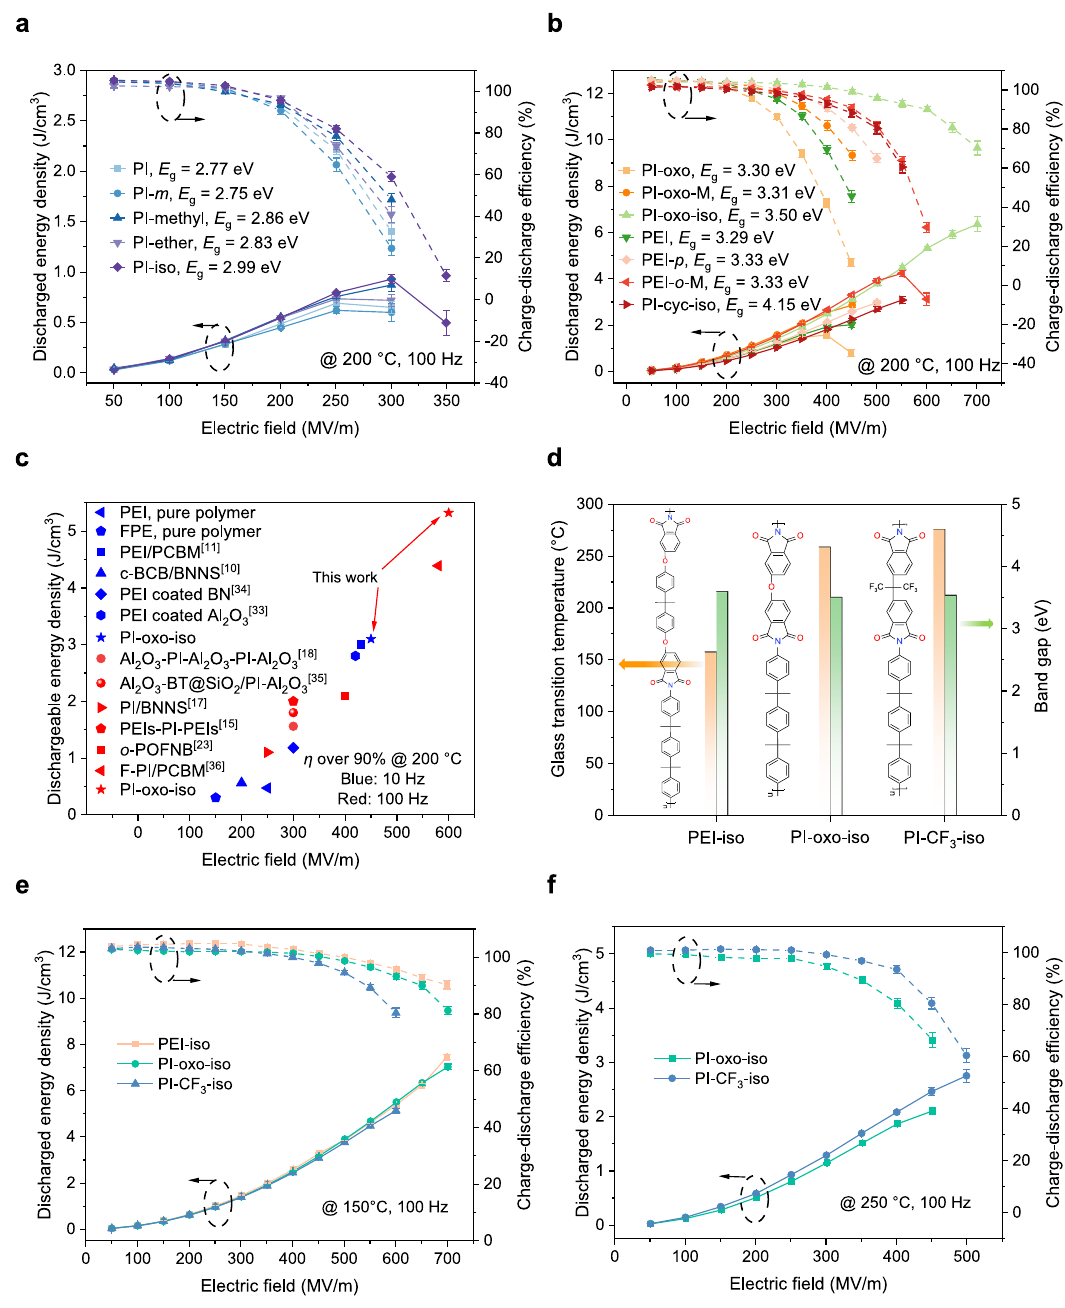
fi eld. d ComparisonofglasstransitiontemperatureandbandgapofPEI-iso,PI-oxo- iso,andPI-CF 3 -iso,thecorrespondingmolecularstructureformulaisshownonthe left side to the column diagram. e , f Discharged energy density and charge- discharge ef fi ciency as a function of electric fi eld of PEI-iso, PI-oxo-iso and PI-CF 3 - isoat150°Cand 250°C.The averagevalues and max – minerror barsofthe results were obtained from six parallel